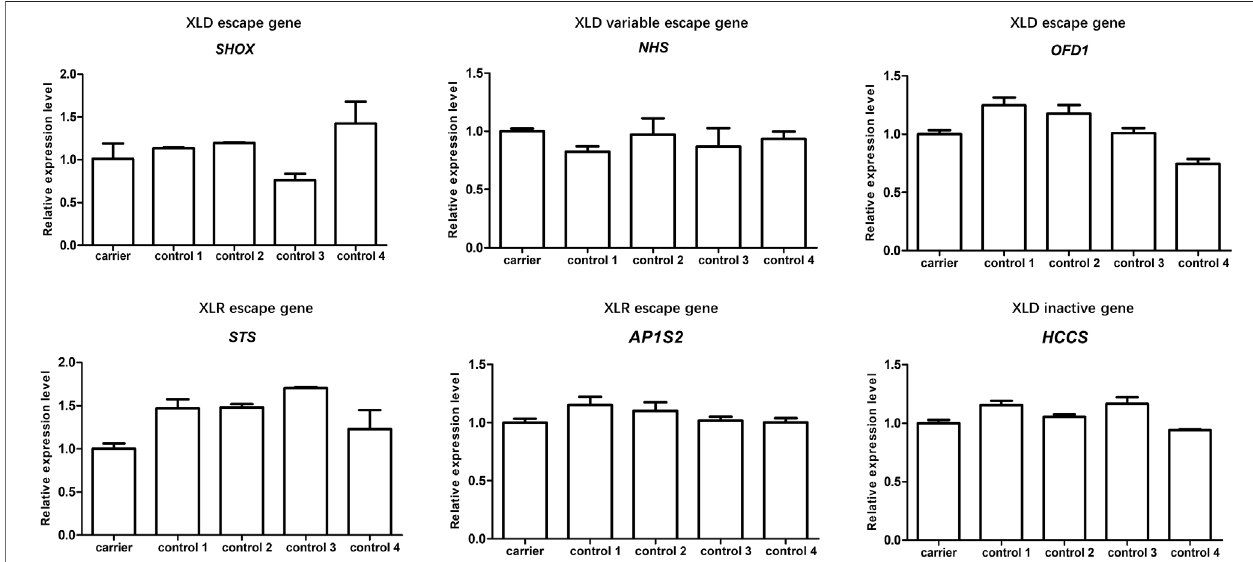
FIGURE3| Theexpressionlevelsofrepresentativegenesinvolvedinthedeletionregionofpedigree3.TotalRNAwasextractedfromperipheralbloodlymphocytes of one female carrier of Xp22.33-Xp22.13 deletion (II-1in of pedigree 3) and four race- and age-matched non-carrier female controls. qRT-PCR was used to detect the expressionofsixrepresentativegeneslocatedinthedeletionregioninthesesamples.TheinheritancemodeandreportedXCIstatusofthesegenehavebeenannotated in the fi gure. The relative levels of these genes are normalized to β -actin expression. Data represents the mean of experiment performed in triplicate; there is no signi fi cant difference among the tested